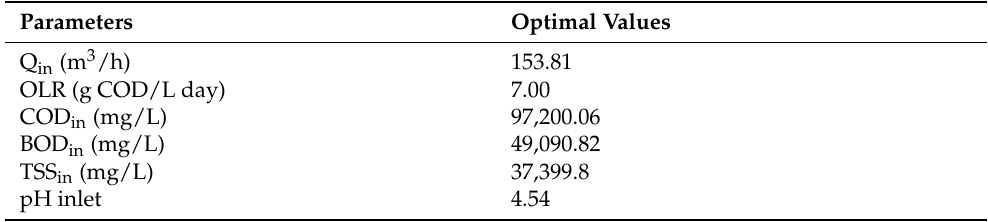
Table 4. Optimal operating condition for maximum COD removal (%) from anaerobic digestion.